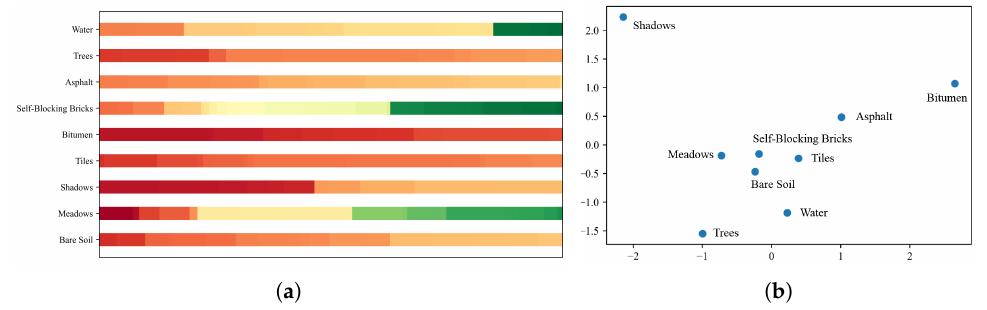
Figure 3. ( a ) Label semantic distributions of the Pavia Center dataset, ( b ) PCA visualization of word embeddings in a two-dimensional